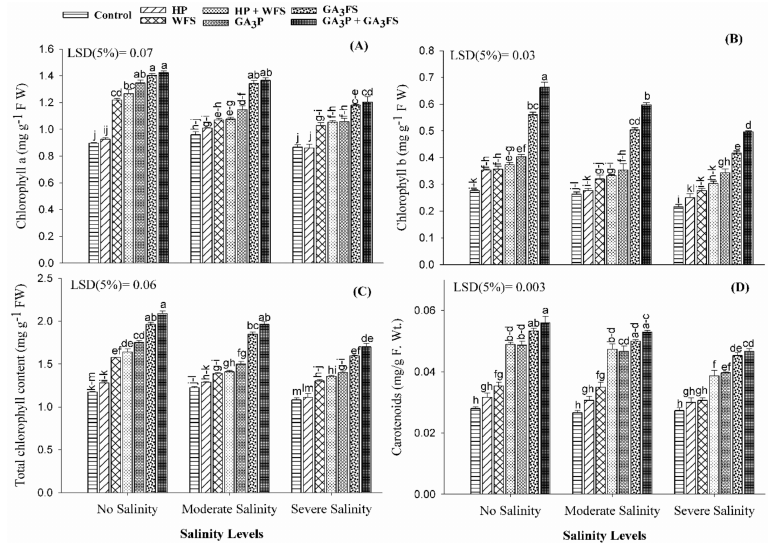
Figure 3. Chlorophyll a ( A ), chlorophyll b ( B ), total chlorophyll ( C ) and carotenoid content ( D ) of maize as affected by different treatments of gibberellic acid under no salinity, moderate salinity (6 dS m − 1 ), and severe salinity (12 dS m − 1 ). Values are means ± SD (n = 3). Hydropriming (HP); water foliar spray (WFS); hydropriming and water foliar spray (HP + WFS); seed priming with GA 3 (GA 3 P); foliar spray with GA 3 (GA 3 FS); seed priming and foliar spray of GA 3 (GA 3 P + GA 3 FS). Bars with the same letters do not differ significantly at p ≤ 0.05.